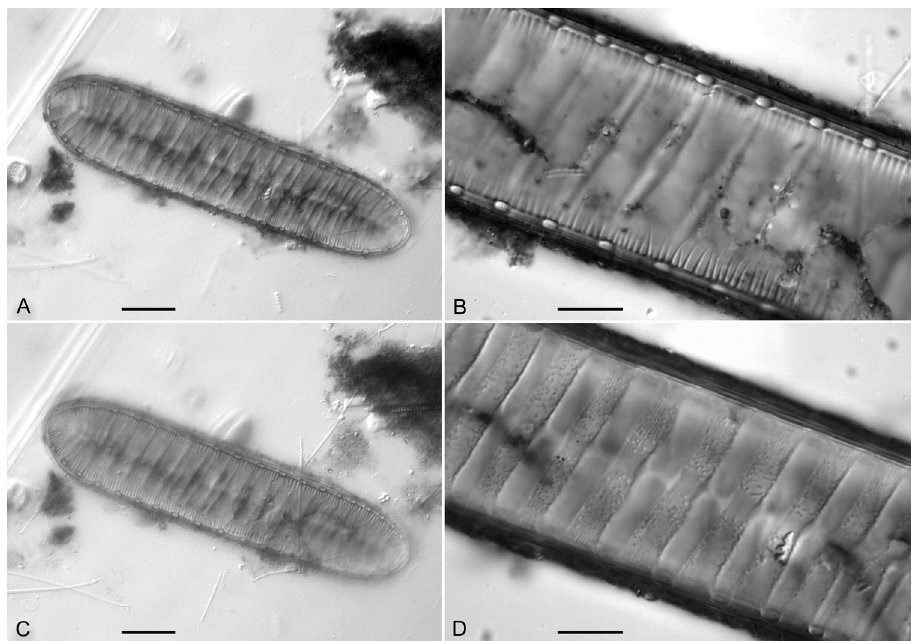
Figure 5. Iconella murielae . Valve from the holotype slide BR 984. A, C Overview of the entire valve at different foci B, D Detail of the middle part of the valve at different foci B is showing the fenestral openings below the raphe canal and D the striae and the transapical undulations. Scale bar for A, C = 20 µm; scale bar for B, D = 10